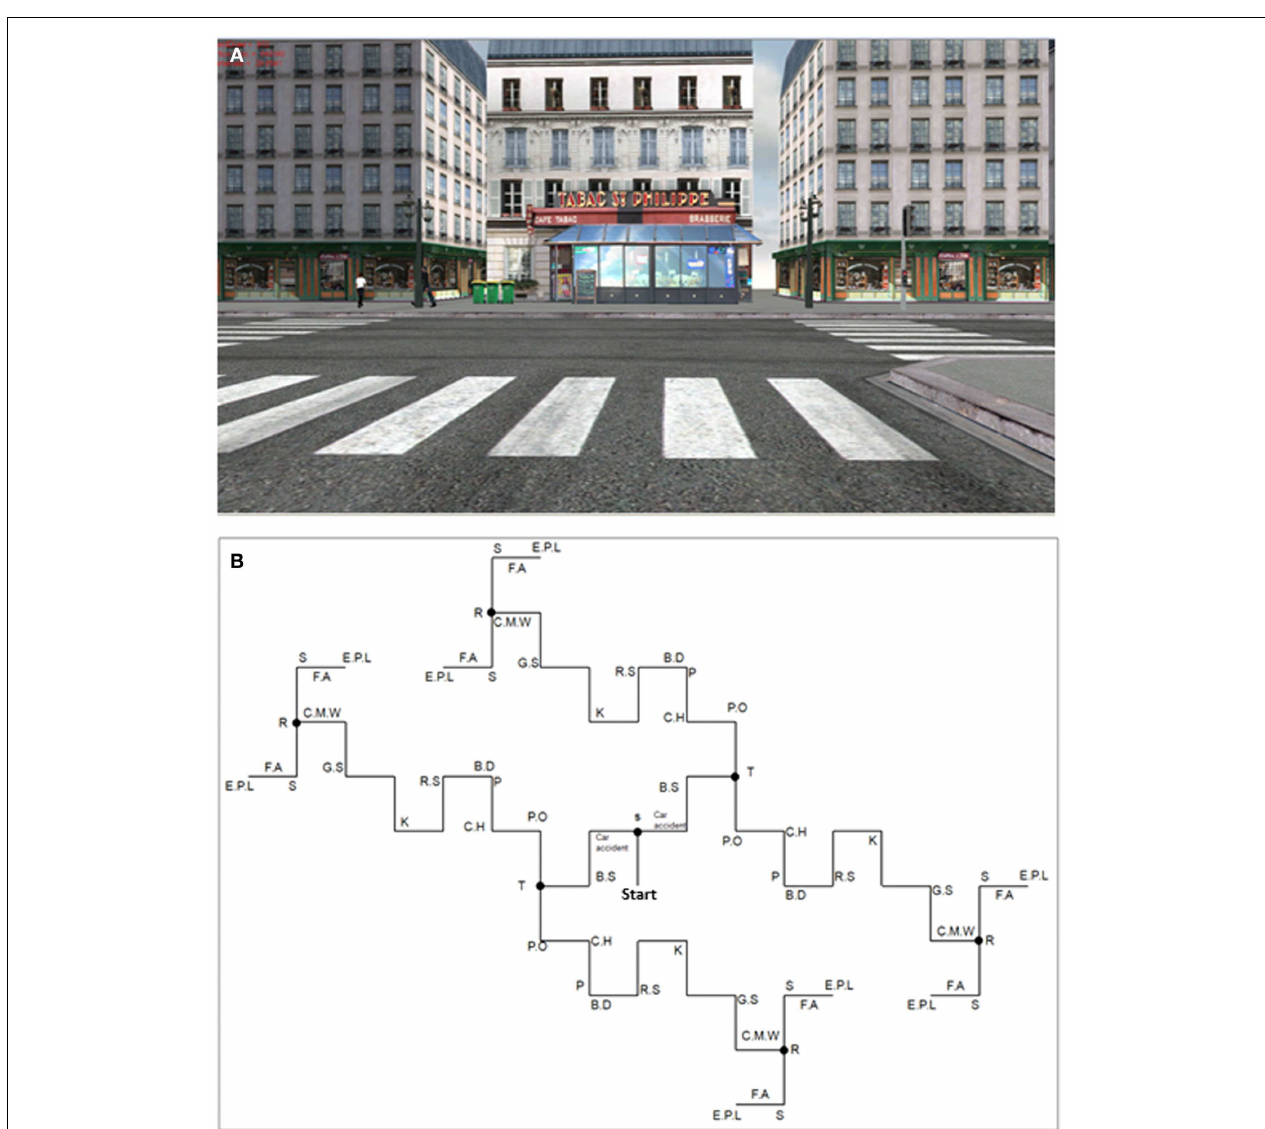
T, tobacco shop; P.O, post-office; C.H, city hall; P, public parking lot; B.D, business district; R.S, road safety sign; K, kebab shop; G.S, grocery store; C.M.W, two cars in the middle of the road; R, restaurants; S, train station; F.A, action against famine sign; E.P.L, external parking